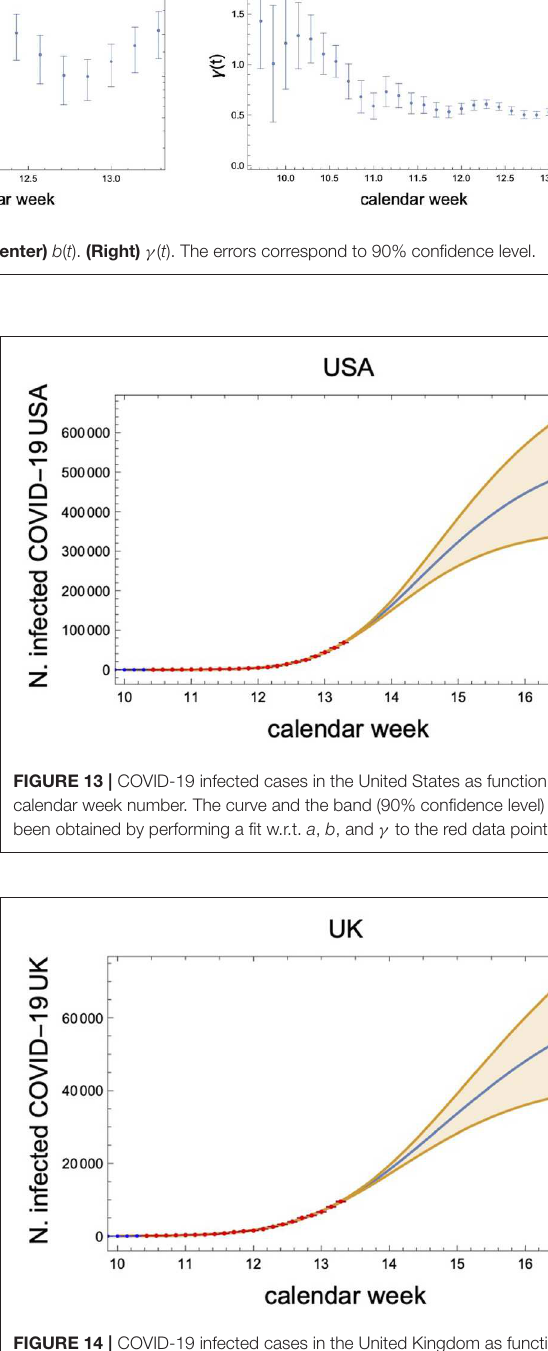
growth phase. Consequently, the estimates for the asymptotic values of the corresponding number of infected cases are more accurate for Italy and for